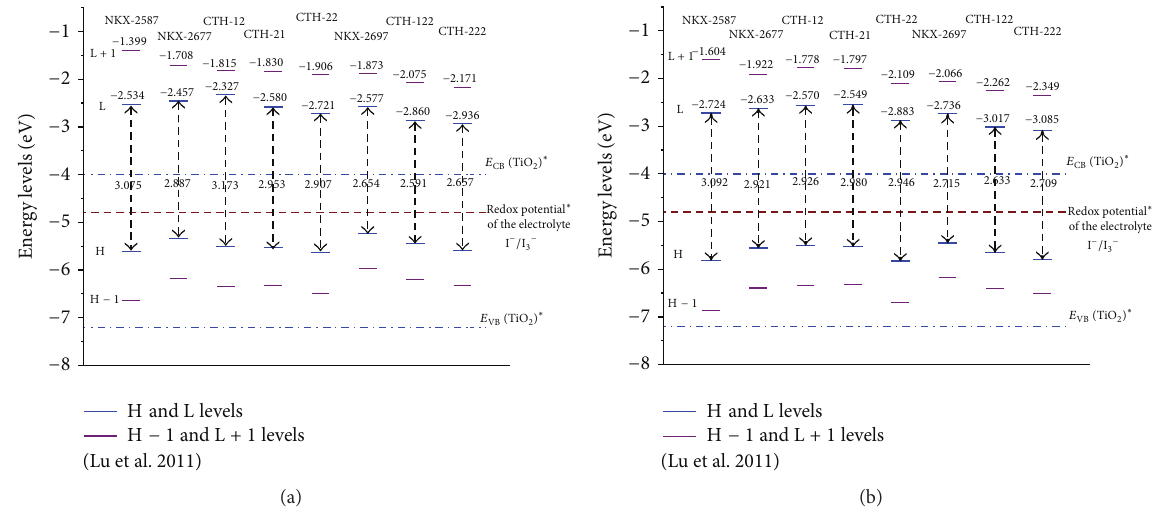
Figure 3: Molecular orbital energy levels of coumarin derivative dyes using the M06 functional and the basis sets: (a) 6-31G(d) and (b) 6-311G(d).